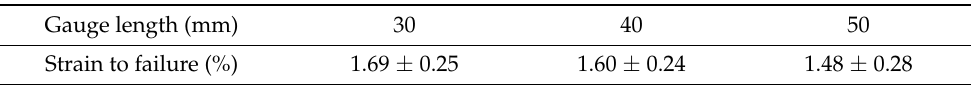
Figure 14. Experimental and fitted stress–strain curves of single carbon fibres tested with gauge lengths of 30, 40, and 50 mm. The datasets is available in reference [29]. Table 4. Strain to failure (%) of single carbon fibres tested with different gauge lengths.